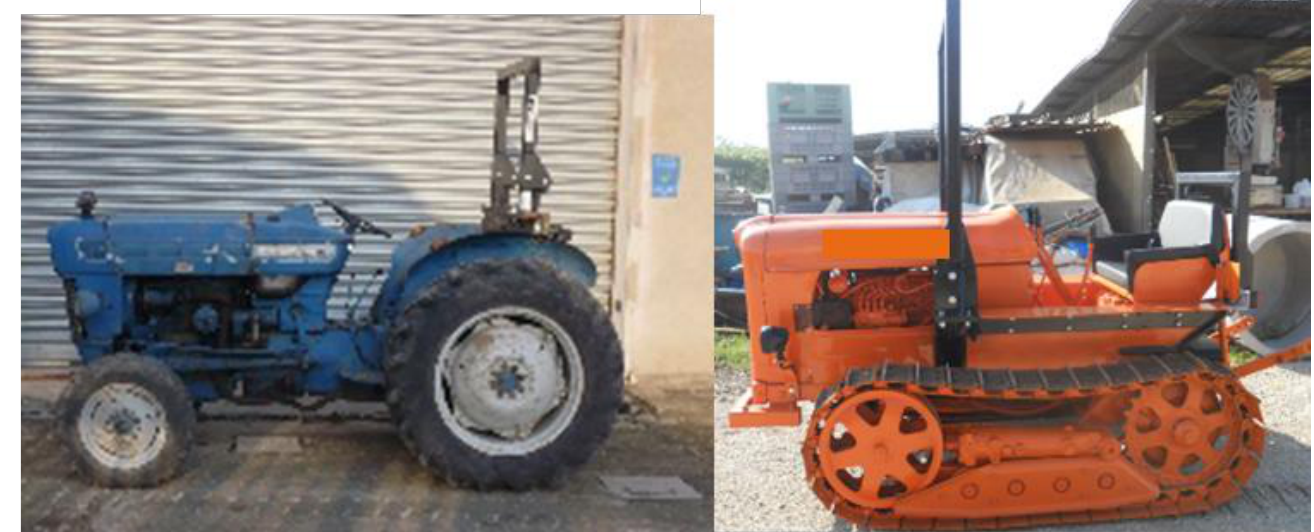
Figure 1. Examples of a rear-mounted FROPS ( left ) and a front-mounted FROPS ( right ).